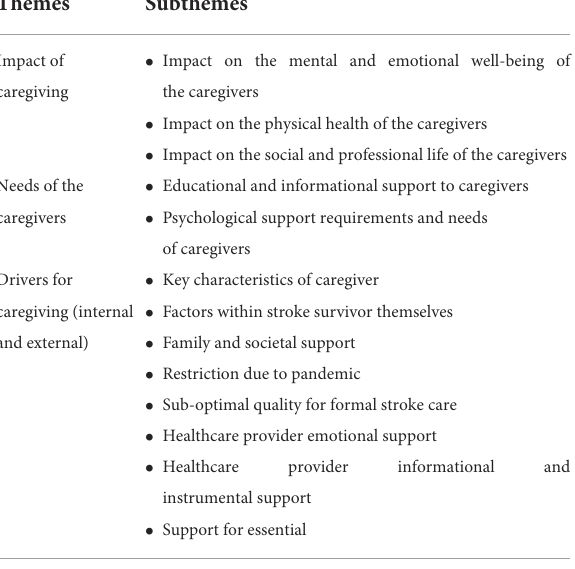
TABLE 2 Participants’ characteristics. TABLE 3 Summary of themes and